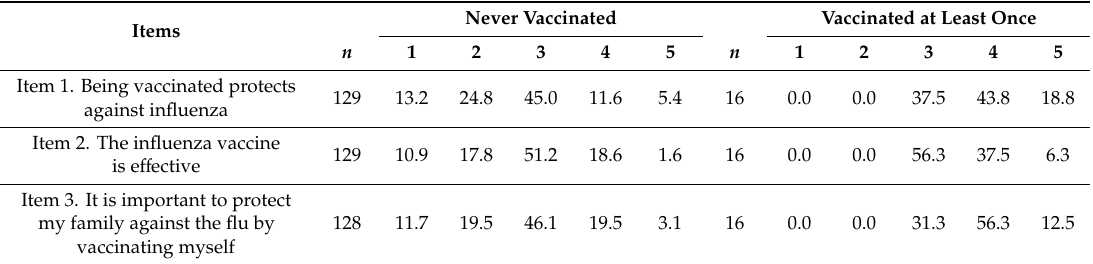
Table A1. Score distribution of the never-vaccinated group (i.e., 0 at Q1) compared to the vaccinated at least once group (i.e., 1–3 for